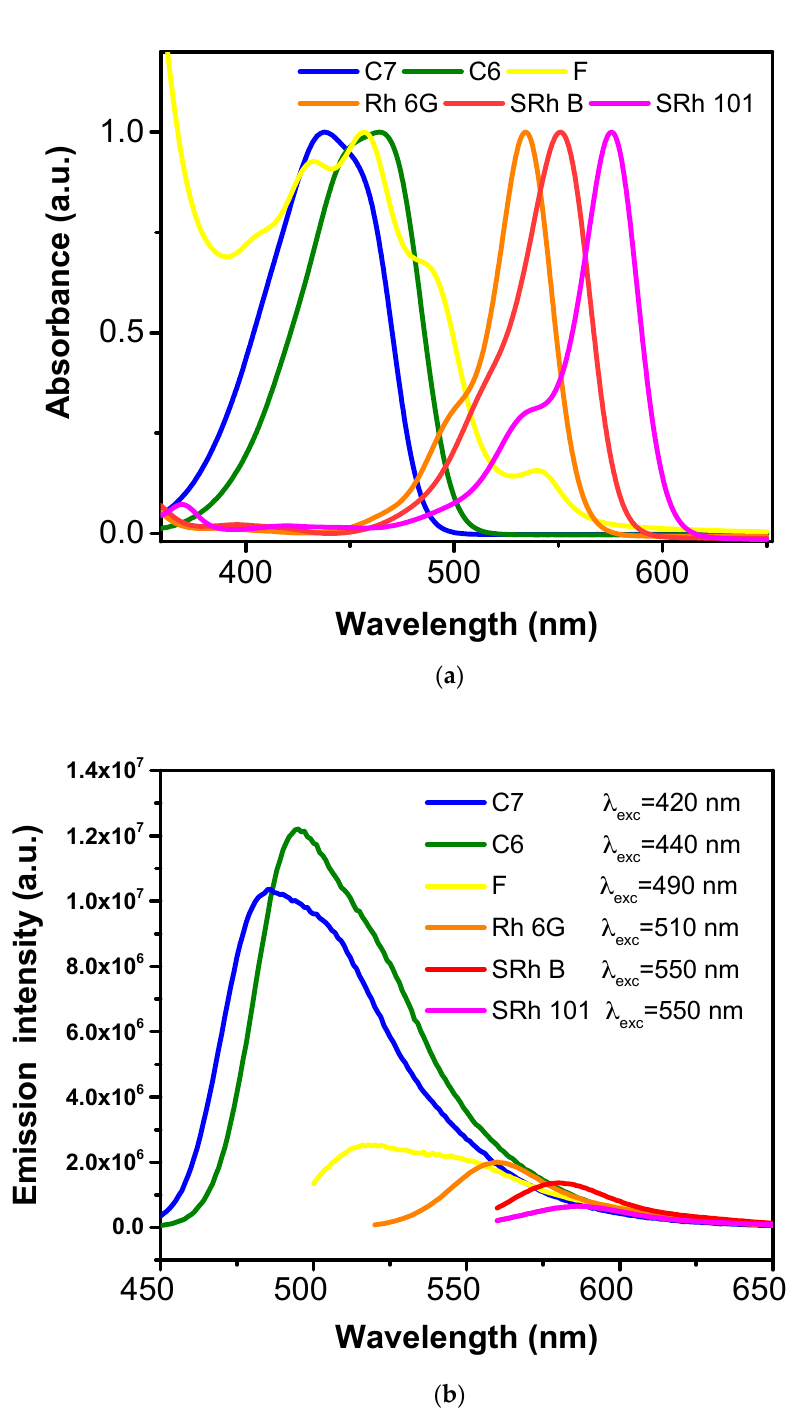
Figure 6. Absorption ( a ), and photoemission ( b ) spectra of single-dye-doped polymer fibers. As expected, the optical absorptions of the single-dye-doped fiber mats covered the spectral domain 400–600 nm with increasing intensities from the blue region towards the red region, while the emissions covered the spectral domain 450–650 nm with higher intensities in the blue-green